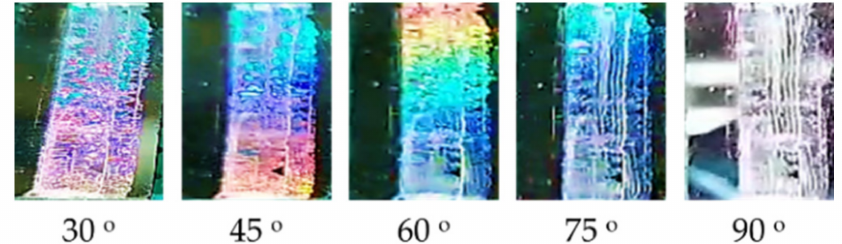
Figure 5. Digital images of the as-prepared PS films deposited on a substrate taken from different angles.